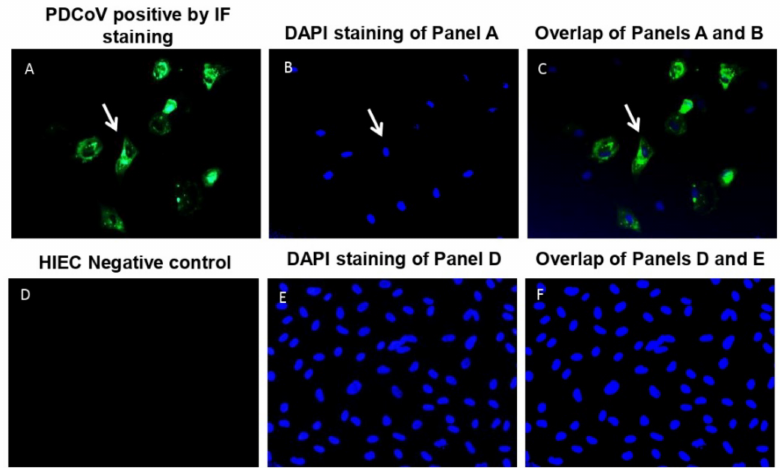
Figure 1. IF staining of the inoculated HIEC cells at 24 hpi. ( A ) IF-stained positive (green fluorescence) for PDCoV antigen. ( B ) Blue-fluorescent 4 (cid:48) ,6-diamidino-2-phenylindole dihydrochloride (DAPI) staining of Panel A to stain nuclear DNA. ( C ) Overlay of panels A and B. The arrowheads indicated cells positive for PDCoV antigen. ( D ) IF staining of PDCoV-un-inoculated (0.05% Trypsin). ( E ) DAPI staining of Panel D. ( F ) Overlay of Panels D and E. Fluorescent images were taken at 300 × total magnification.